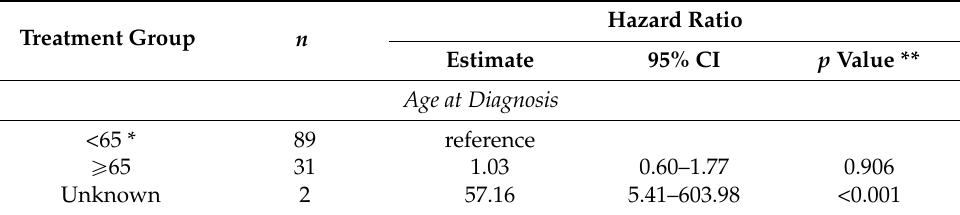
Table 3. Multivariate hazard ratios, confidence intervals, and p